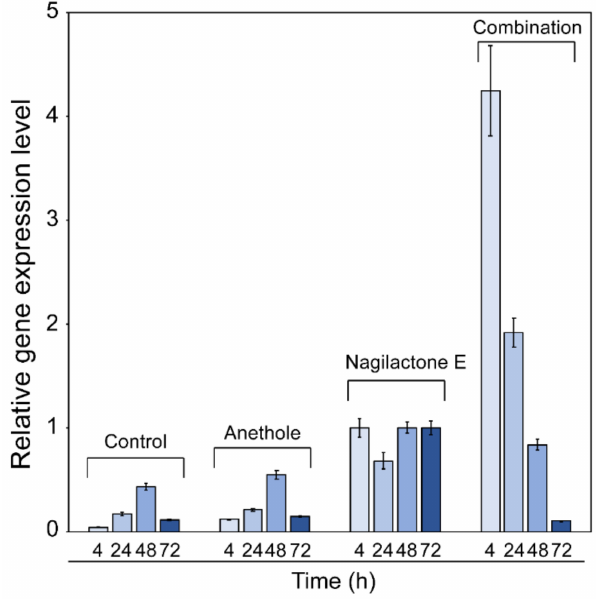
Figure 4. Relative gene expression of PDR5 in S. cerevisiae BY4741. Exponentially growing cells were grown at 30 ◦ C in 2.5% ME treated with 312.5 µ M anethole, 250 µ M nagilactone E, or their combination. Control denotes treatment without drugs. Total RNA was then extracted and analyzed by RT-qPCR. Gene expression is shown relative to ACT1 expression. Data are expressed as the mean ± standard deviation (n =